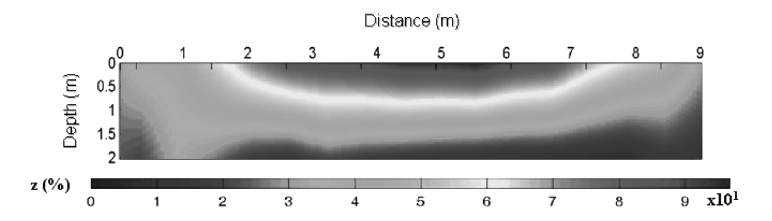
Fig. 5. distribution of ray path density values z